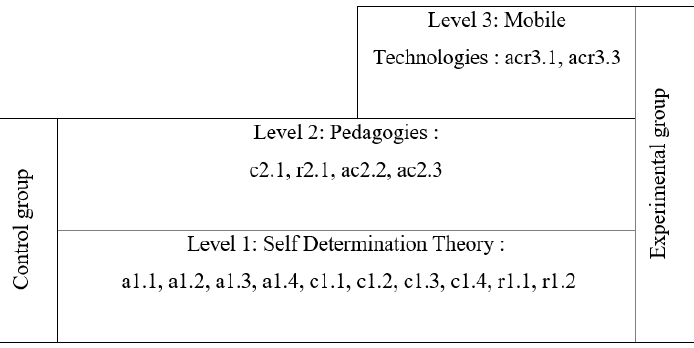
Figure 5. Implemented components of the framework.